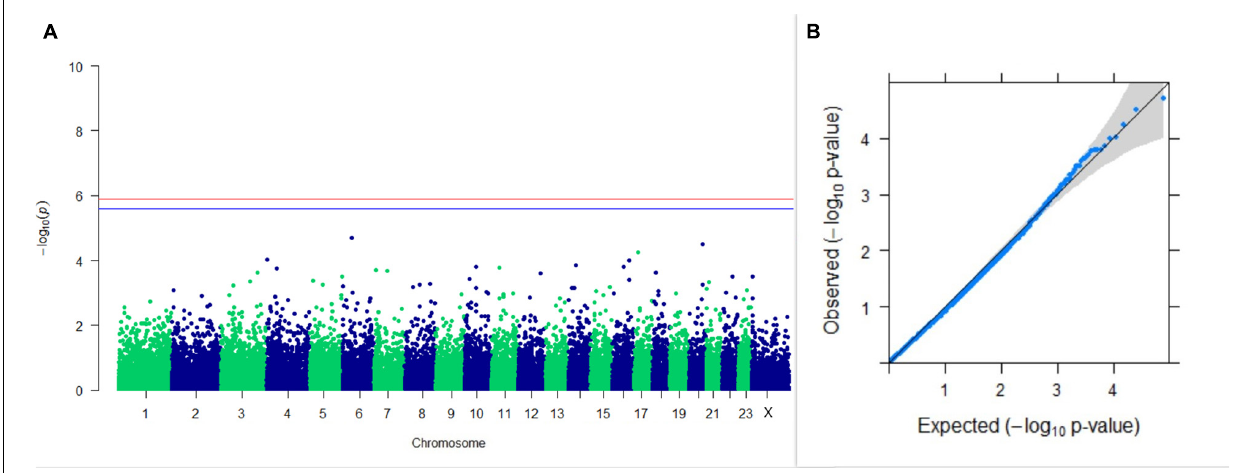
FIGURE 3 | Results of GWAS for PC1 of the test day’s fat percentage. (A) Manhattan plot of genome-wide SNPs. The red line indicates the p- value threshold (expressed as –log 10 P ) corresponding to FDR-corrected p- values or q = 0.05, above which the SNPs are considered to be significantly associated with the trait, while the blue line indicates the genome-wide suggestive threshold at q = 0.1. The SNPs identified on chromosome no. 24 were screened out from analysis because of stringent quality control; hence, it is not represented in the Manhattan plot. (B) Q-Q plot of the p- values.